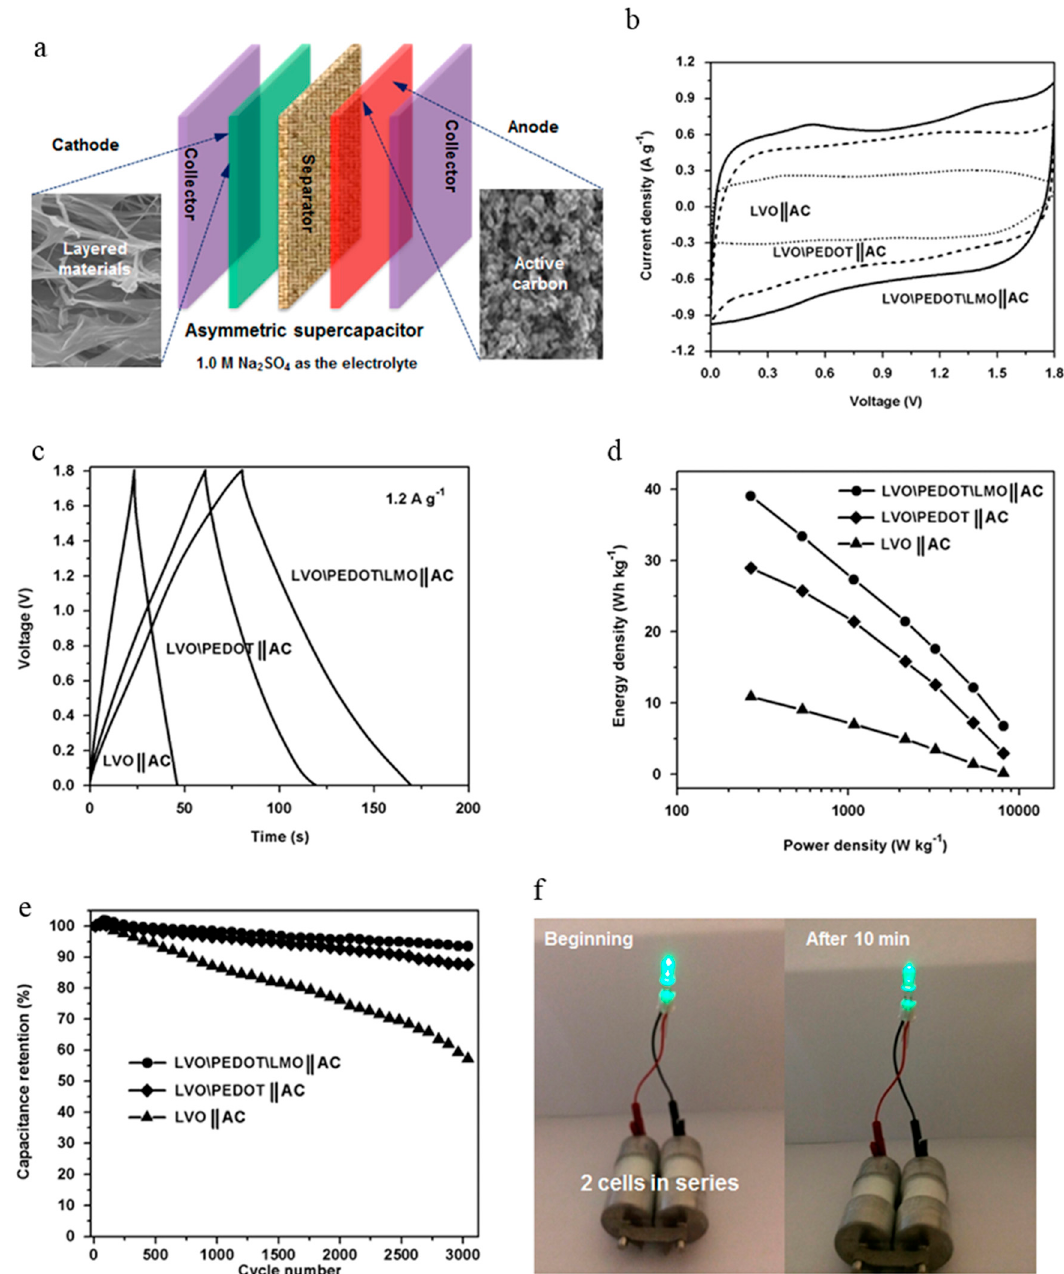
Figure 20. ( a ) Configuration of the asymmetric supercapacitors. ( b ) CV curves of asymmetric supercapacitors with a voltage window of 1.8 V at a scan rate of 25 mV·s − 1 . ( c ) Charge-discharge measurements of asymmetric supercapacitors at a current density of 1.2 A·g − 1 . ( d ) Ragone plots of the asymmetric supercapacitors calculated from charge-discharge curves based on the total mass of active materials. ( e ) Cycle performance of the asymmetric supercapacitors at 6 A·g − 1 . ( f ) Digital images of a green LED powered by two LVO/PEDOT/LMO//AC supercapacitors connected in series [148] .